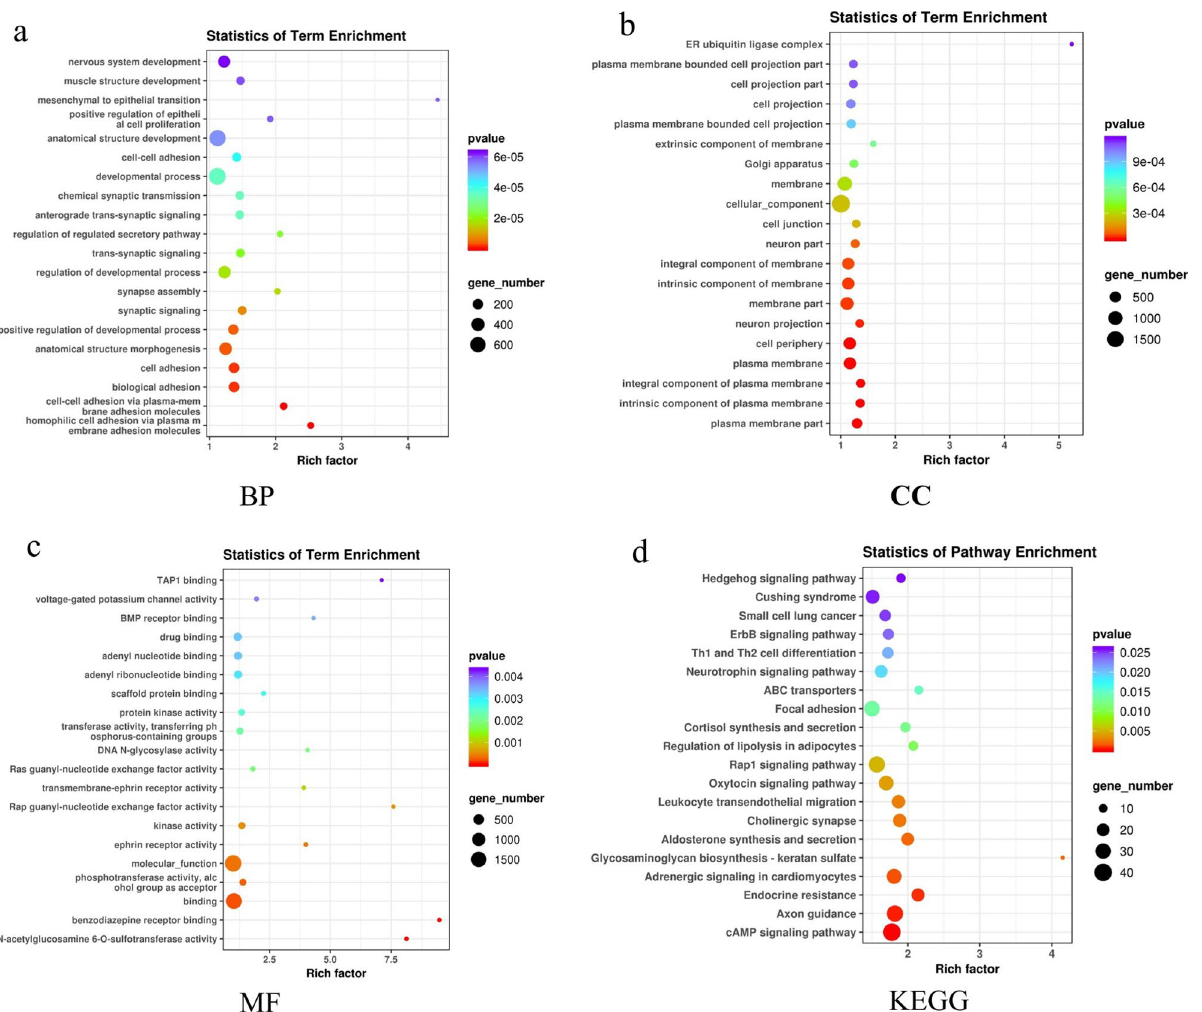
Figure 5. GO enrichment and KEGG pathway analysis of the 22 DEMs comparing SCLC and NSCLC. Advanced bubble chart shows enrichment of genes in signaling pathways. BP, biological processes; CC, cellular component; MF, molecular